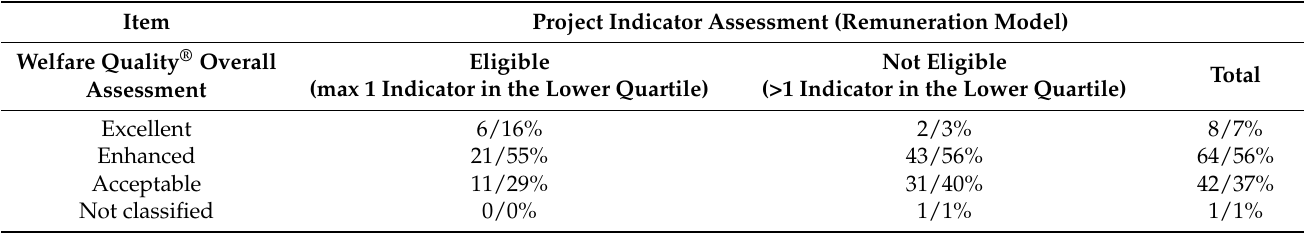
Table 4. Welfare Quality ® assessment in comparison to the qualification of farms to participate in a results-oriented support measure. Item Project Indicator Assessment (Remuneration